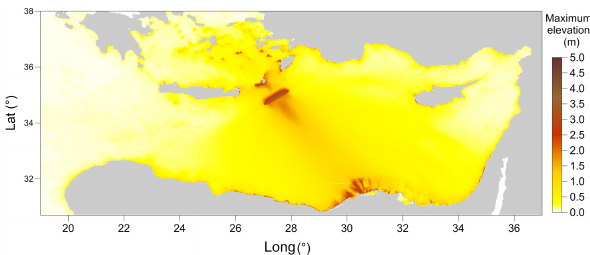
Figure 7. Sea surface maxima in grid 1 for the tsunami generated by the eastern Hellenic Arc (EHA) earthquake (see Table 1 for details).